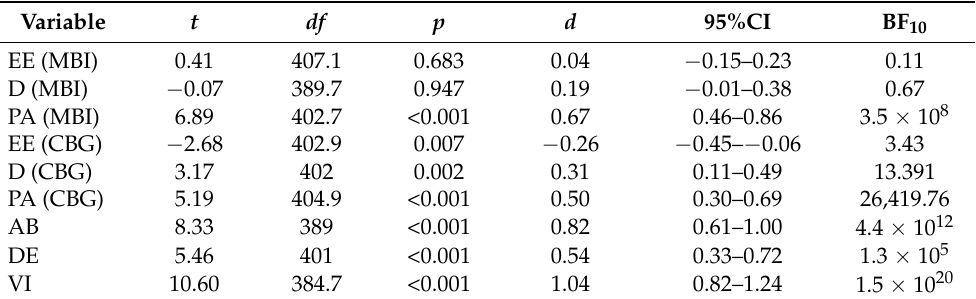
Table 3. Effects of the pandemic on burnout and engagement according to the different hypothe- sis tests.